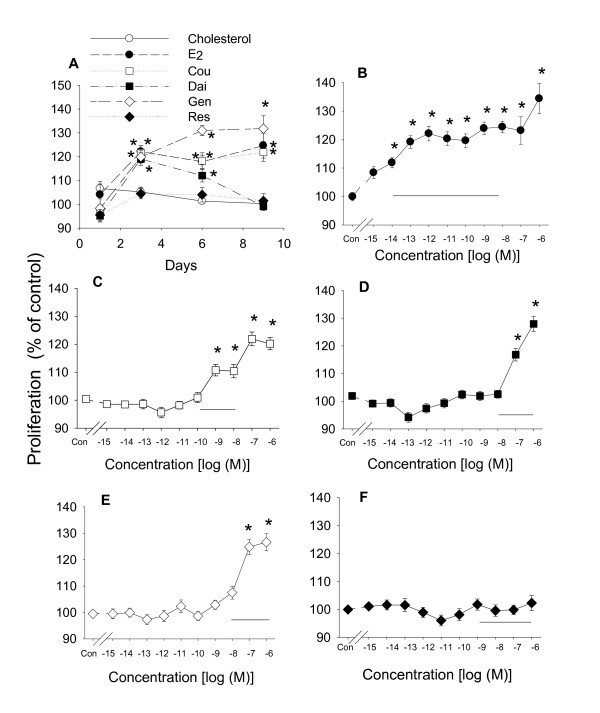
Proliferative effects of E2 and phytoestrogens on GH3/B6/F10 cells. (A) Cells treated with physiological or dietary levels of estrogens: 10-9 M E2, 10-8 M coumesterol (Cou), 10-7 M cholesterol (negative control), daidzein (Dai), genistein (Gen), or trans-resveratrol (Res) over a 9 day time course. Cell proliferation was measured by the crystal violet assay. (B-F) Dose-response profiles of the proliferative effects of different concentrations of estrogens after 3 days of treatment. (B) E2, (C) coumesterol, (D) daidzein, (E) genistein, and (F) trans-resveratrol. The solid horizontal line spans the reported concentrations of each estrogen in human serum or urine. * = p < 0.05 compared to vehicle-treated cells.